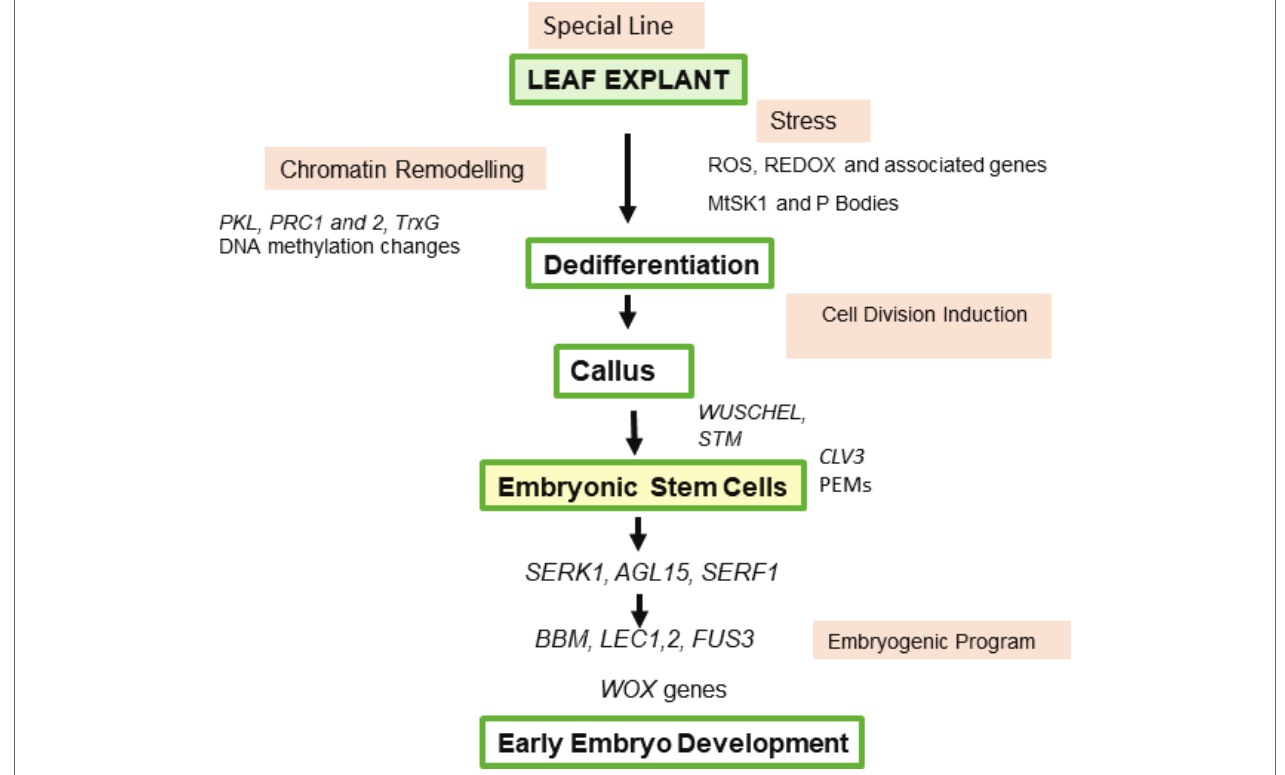
FIGURE 5 | Model for sequence of events in somatic embryogenesis from M. trunctula leaf explants. Excision and plating of the explant produce ROS that probably in interaction with hormones cause chromatin remodeling involving PKL , PRC complexes, and TRITHORAX genes, and a stress kinase that maybe linked to transcript degradation via RNA processing bodies. Cell divisions follow and callus is produced. Cytokinin-dependent WUS expression is essential for SE and there is an initial expression analogous to that occurring in the ovule followed by stem cell development linked to PEMs in patches on the callus, correlating with CLV3 and STM expression. AGL15, SERK, and SERF are part of the correct hormone milieu leading to expression of BBM and LEC genes and the embryogenic program. The changes diagramed go hand in hand with hormonal changes. Auxin is initially high then lowers as differentiation starts, followed by auxin regulation associated with embryo patterning in the formation of the bipolar embryo. Cytokinin is important for specific genes and the cell cycle. Endogenous ethylene is produced and endogenous ABA/GA ratios specific to M. truncatula influence SE. Ethylene, ABA, and GA can be involved in regulating auxin responses. Abbreviations are in the